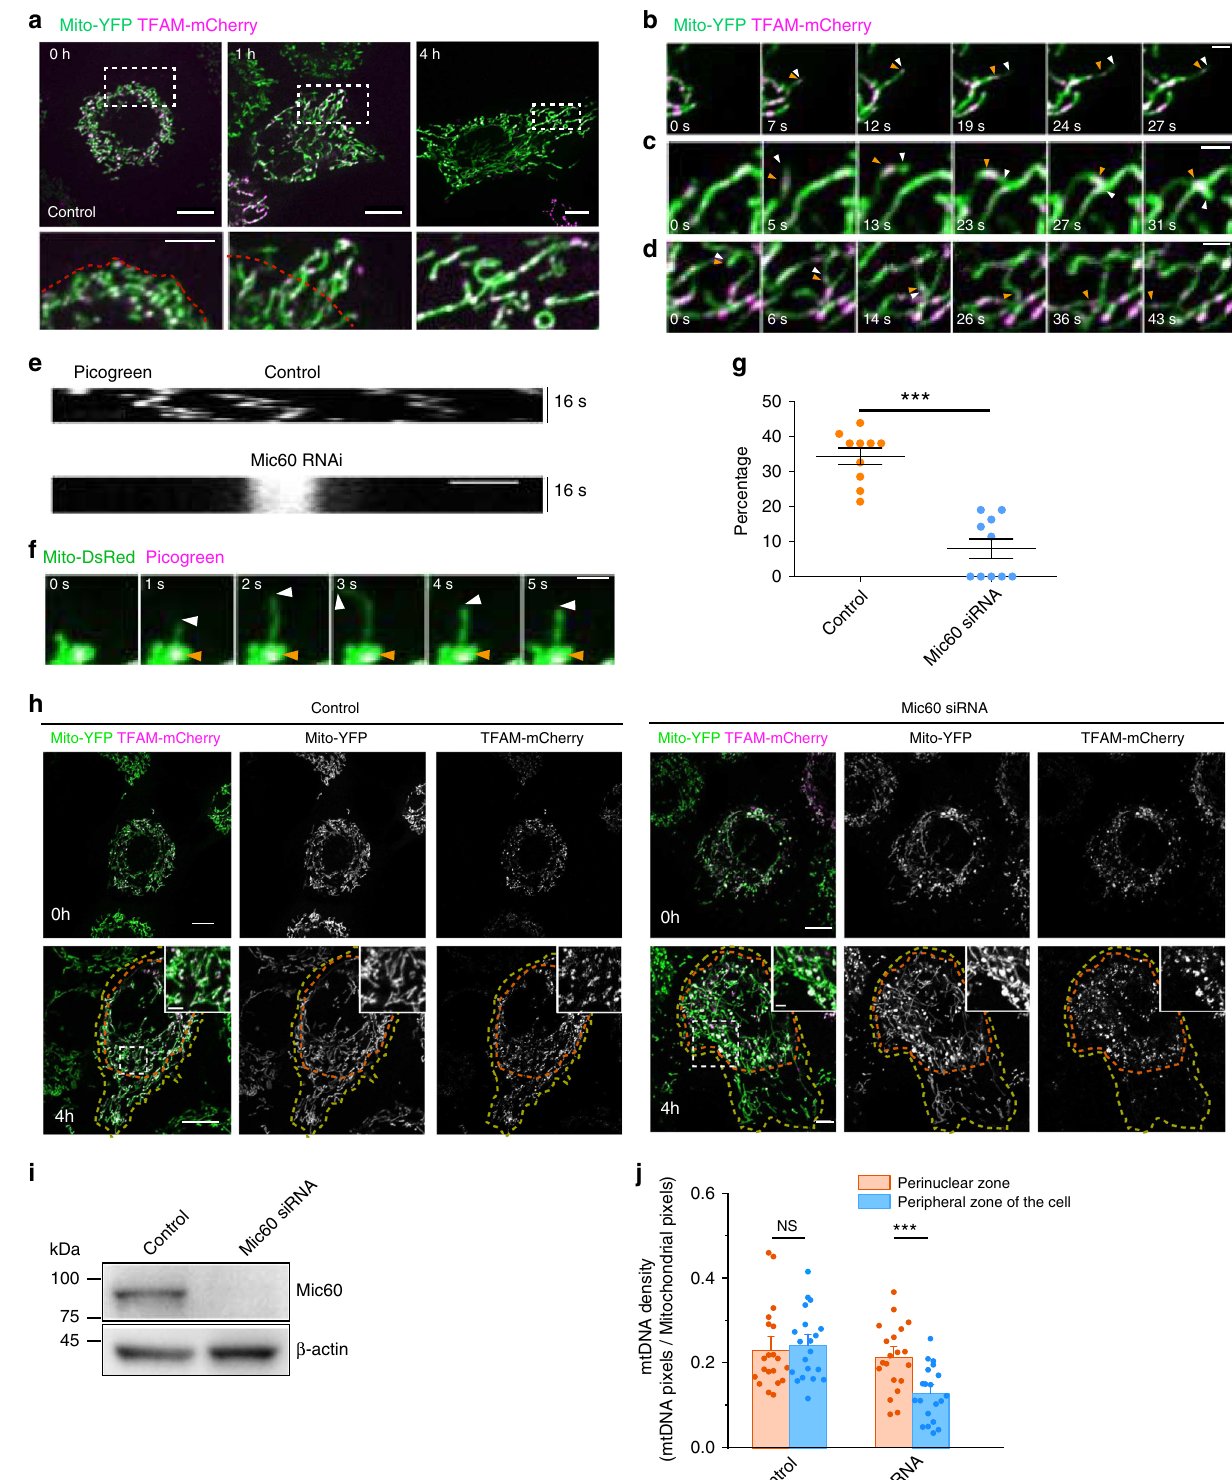
(WH0055288M1; Sigma-Aldrich), 1:200 dilution; anti-Mito fi lin, rabbit polyclonal (10179-1-AP, Proteintech), 1:1000 dilution; anti-Mito fi lin, mouse monoclonal (ab110329, Abcam), 1:500 dilution; anti-KIF5B, rabbit monoclonal (ab167429, Abcam), 1:1000 dilution; anti-Mitofusin1, rabbit monoclonal (ab57602, Abcam), 1:1000 dilution; anti-Mitofusin2, rabbit monoclonal (ab124773, Abcam), 1:1000 dilution; anti-DRP1, rabbit monoclonal (ab184247, Abcam), 1:1000 dilution; and anti- β actin, mouse monoclonal (sc-47778, Santa Cruz Biotechnology),